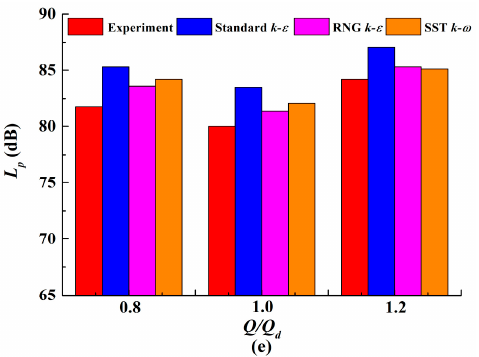
Figure 16. Radiated noise level of simulations and experiment for different monitoring points of ( a ) M1, ( b ) M2, ( c ) M3, ( d ) M4, and ( e ) M5.